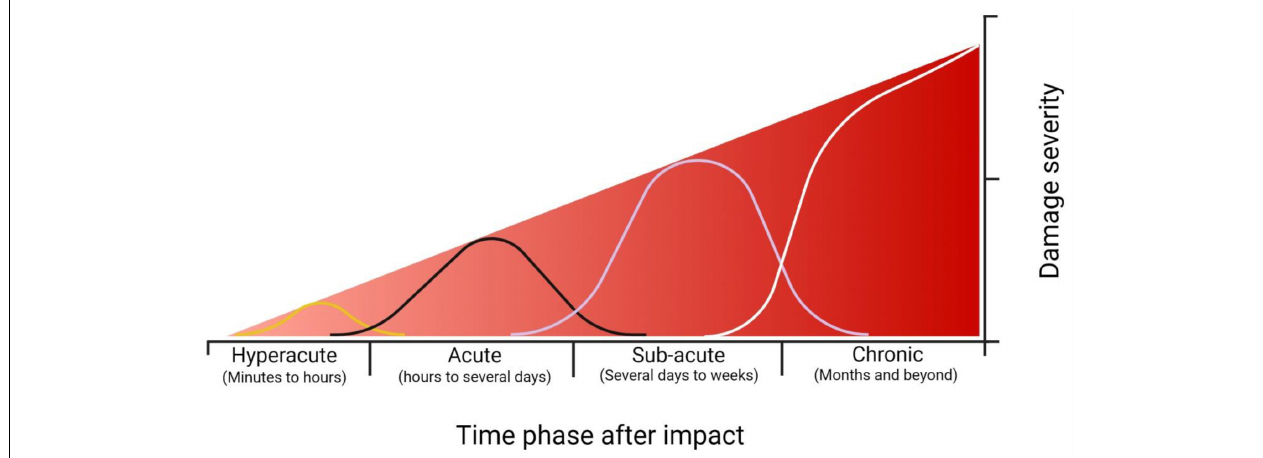
FIGURE 1 | Timescale representation of the severity of damage following impact. Each time phase has the capacity to re-establish homeostasis through cellular repair or some form of treatment. If the cellular homeostasis is unresolved, however, the damage severity increases as time progresses. At the hyperacute time phase (minutes to hours) the damage severity is low, consisting of focal changes at the synaptic level such as hyperexcitability, increased membrane permeability (either through membrane disruption or receptor activity), and onset of excitotoxic conditions. During the acute phase (hours to several days), damage consists of further receptor alterations, activation of proteases and apoptotic pathways, mitochondrial dysfunction, and prolonged excitotoxic conditions. During the subacute phase (several days to weeks), regional deficits within the brain are observed due to cellular dysfunction, prolonged neuroinflammation, and onset of phosphorylated tau accumulation. During the chronic phase (months and beyond), major behavioral deficits and neuropsychiatric conditions are observed, including, but not limited to, impaired learning and memory, depression, and prolonged headaches. The neuropathology of chronic traumatic encephalopathy is also observed during this